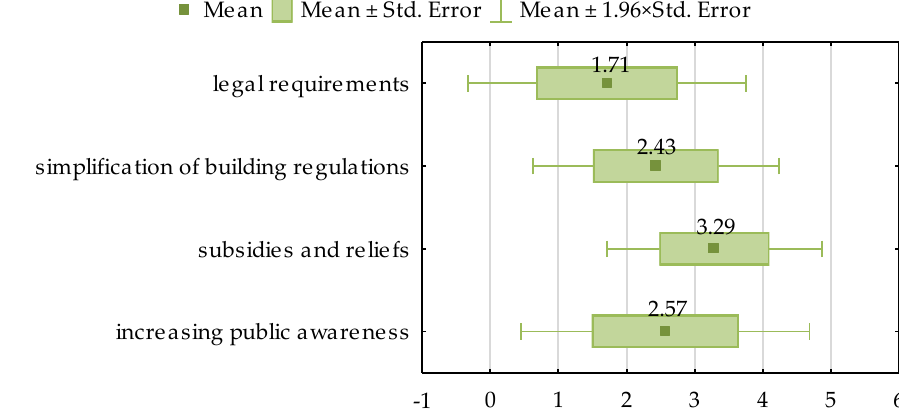
Figure 12. Assessment of the activities increasing interest in net-zero-energy buildings.